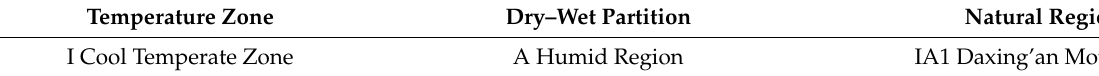
Table 1. Codes of eco-geographical